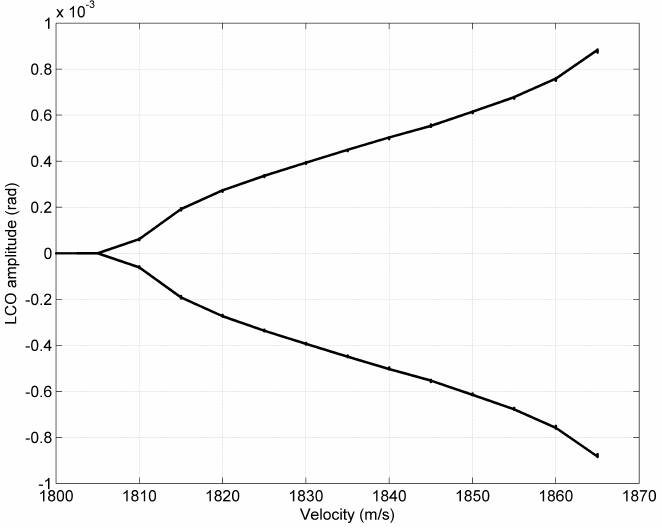
Figure 9. Bifurcation plot for steady-state heat